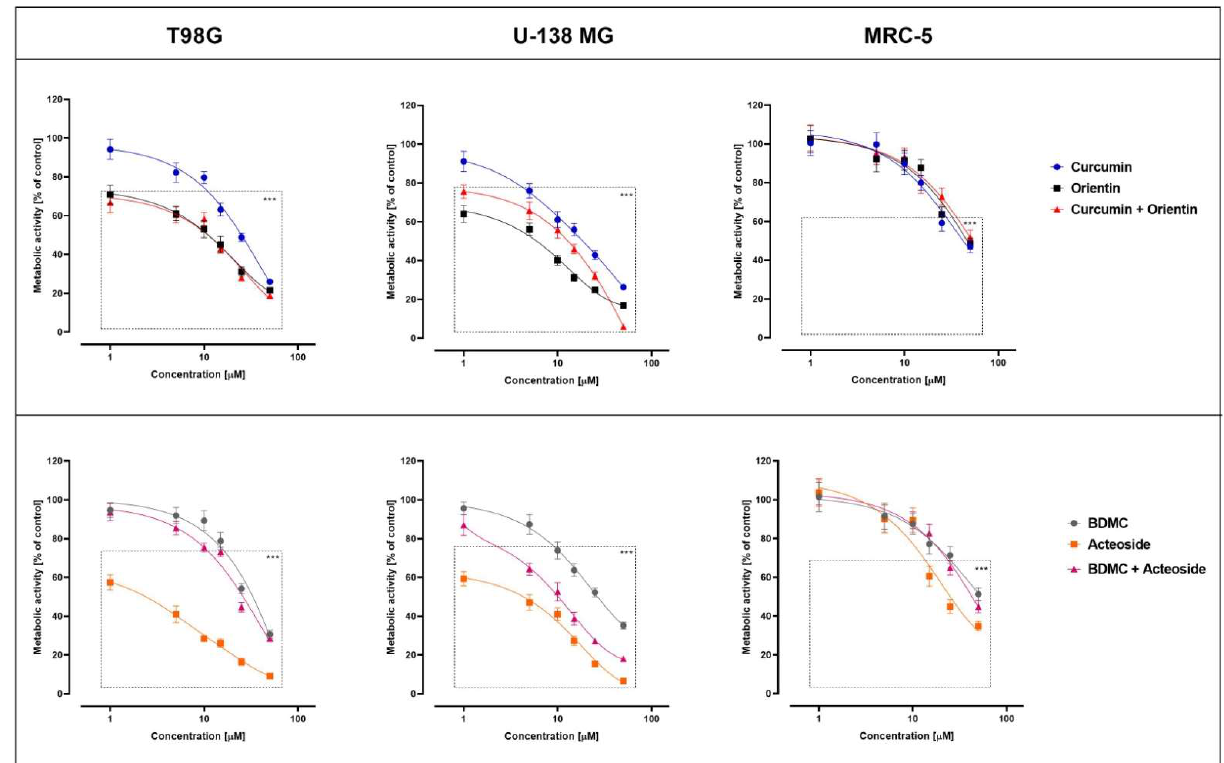
Figure 10. The cytotoxic activity of liposomal formulation containing CUR, BDMC, ACT, ORI and their combination against T98G, U-138 MG, and MRC-5 cells. Data are expressed as the mean ± SEM from three independent experiments; BDMC—bisdemethoxycurcumin. Statistical significance was assessed by Tukey’s test (*** p < 0.001).